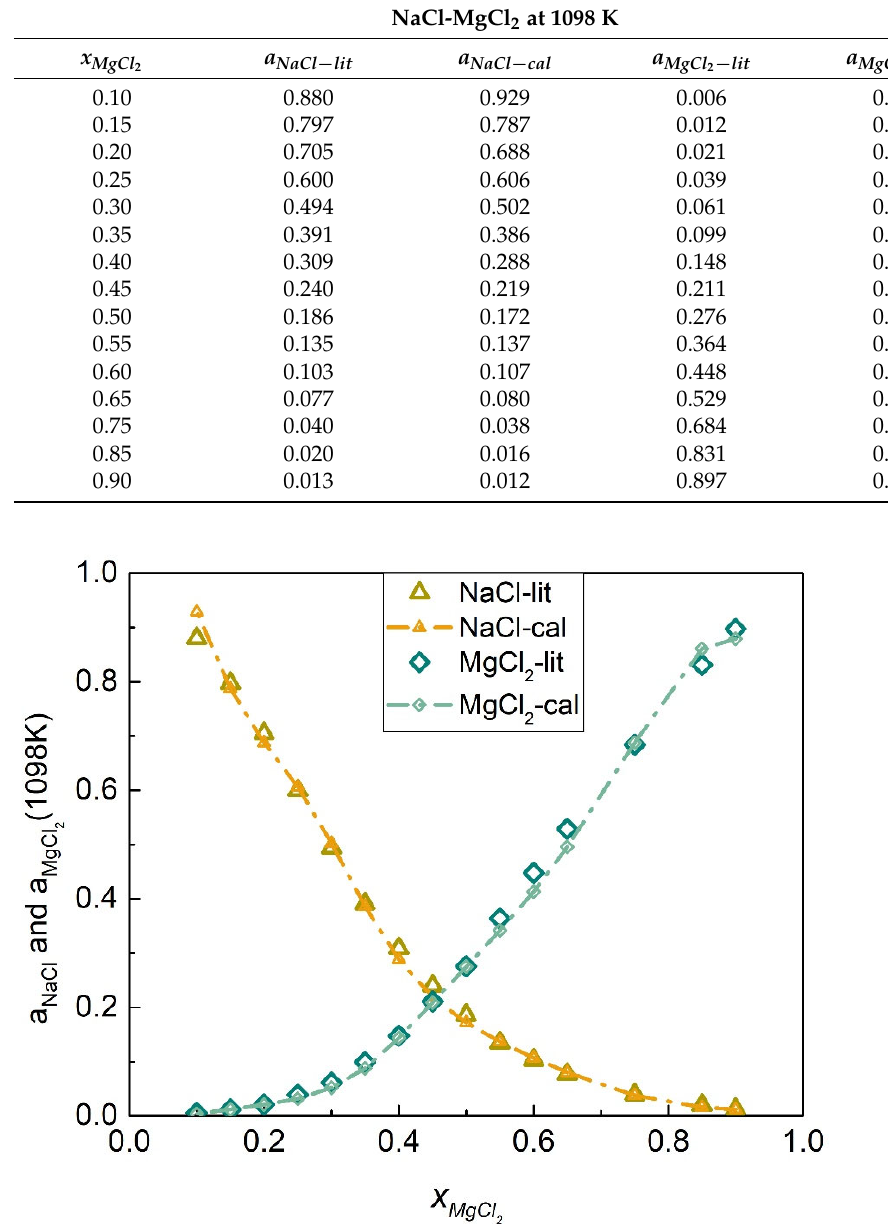
Table 4. Calculated activity values and literature data of the NaCl-MgCl 2 binary chloride system at 1098 K.